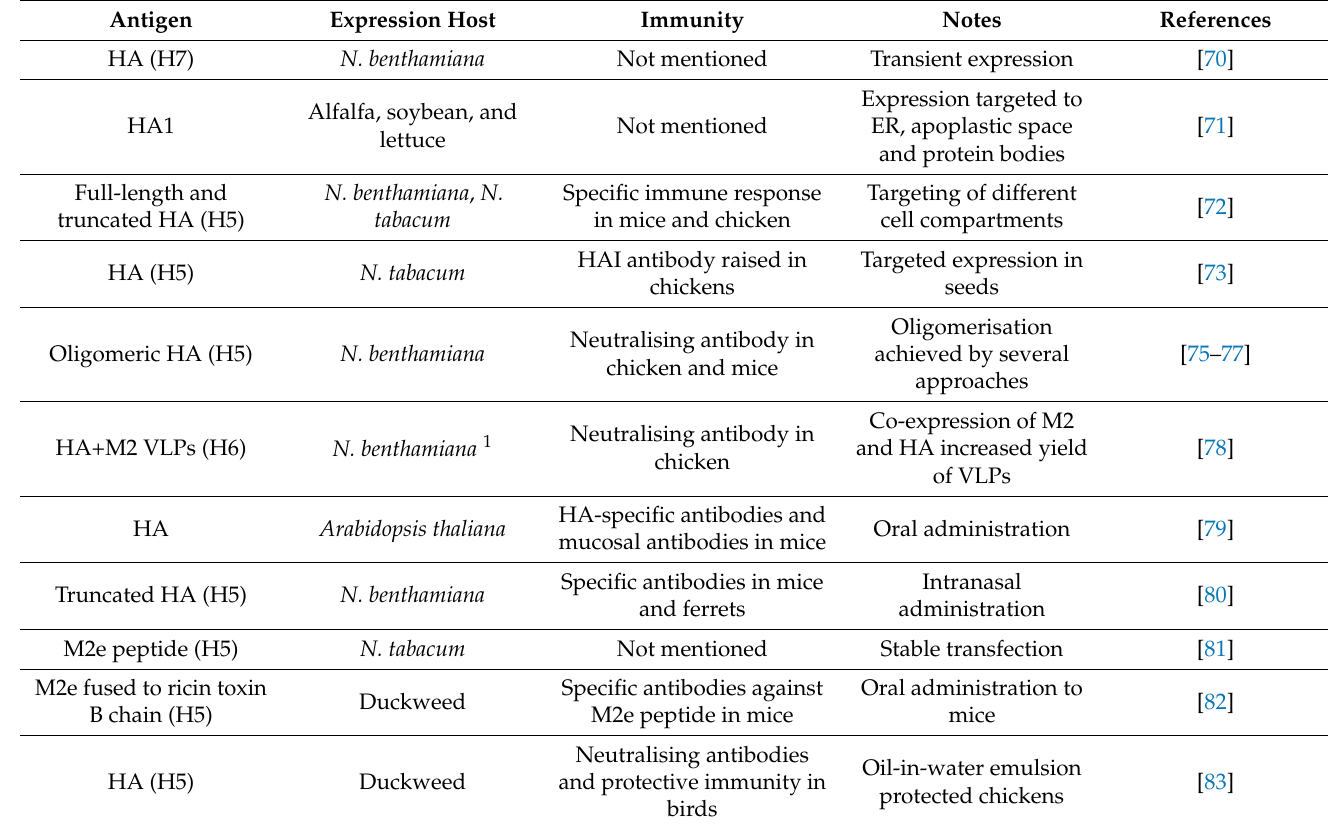
Table 3. Examples of avian influenza plant-based